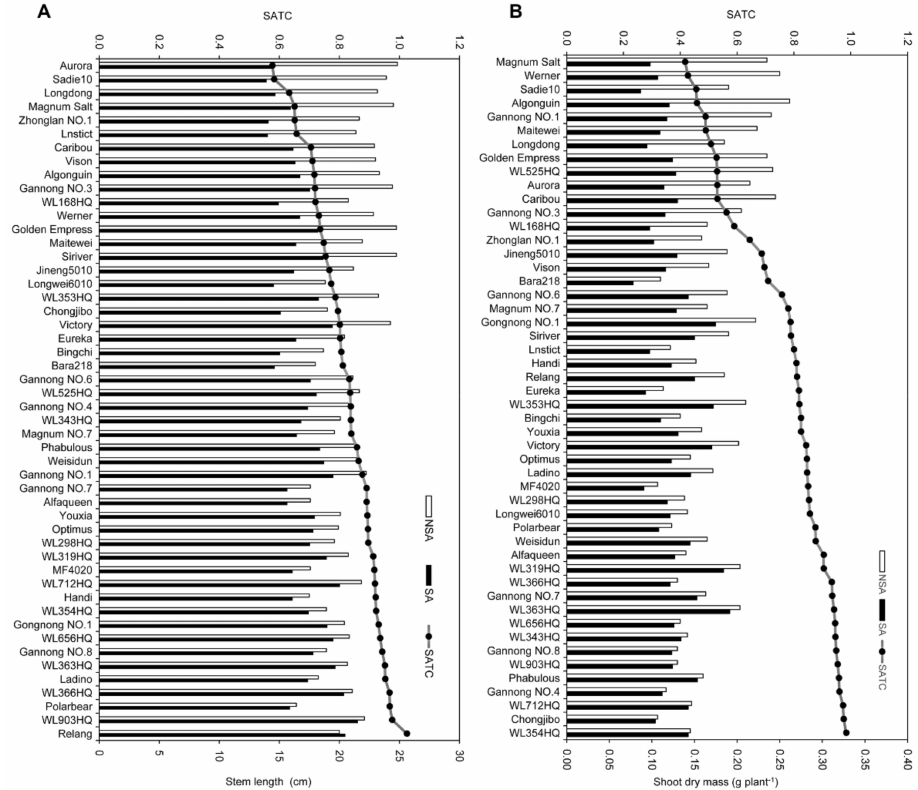
Figure 1. The stem length (SL) (A) and shoot dry mass (SDM) (B) of 50 alfalfa cultivars field-grown in nonsaline-alkaline (NSA) (open bar) soils and saline-alkaline (SA) (solid bar) soils during the seedling stage. The line represents the SA-tolerance coe ffi cient (SATC). Values are the means of absolute values, n =